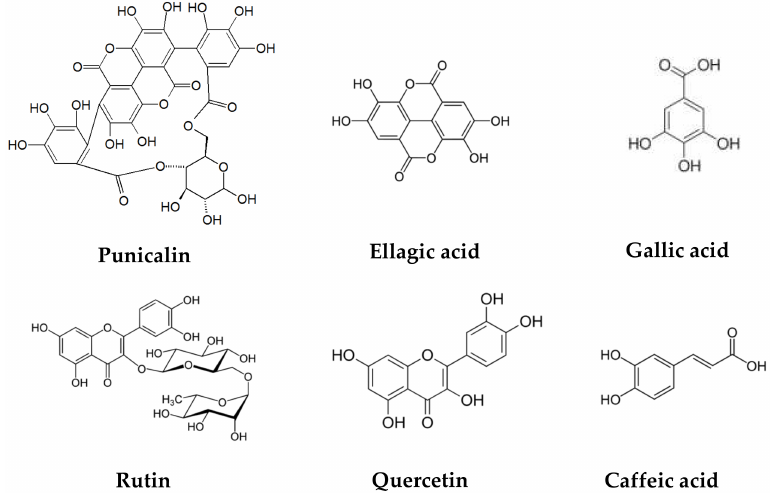
Figure 2. Chemical structures of polyphenols present in pomegranate